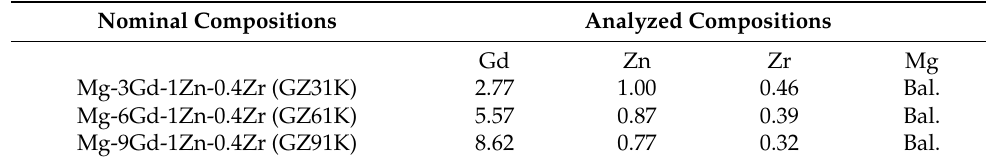
Table 1. Nominal and analyzed compositions of the alloys (wt%). Nominal Compositions Analyzed